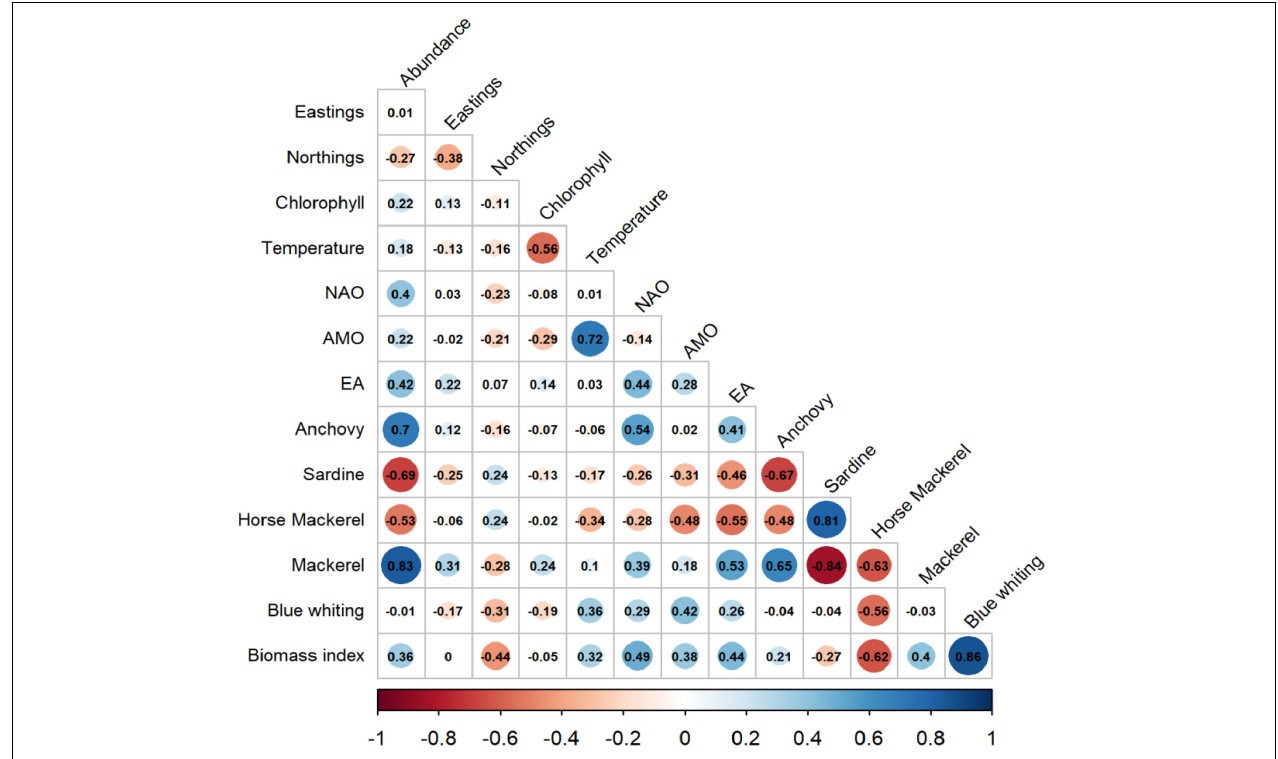
FIGURE 6 | Pearson correlation among the common dolphin’s predicted abundance, CoG and potential drivers. Circle sizes are proportional to the correlation coefficient, which is indicated inside the circles. Non-significant correlations ( p > 0.05) are shown without a circle.